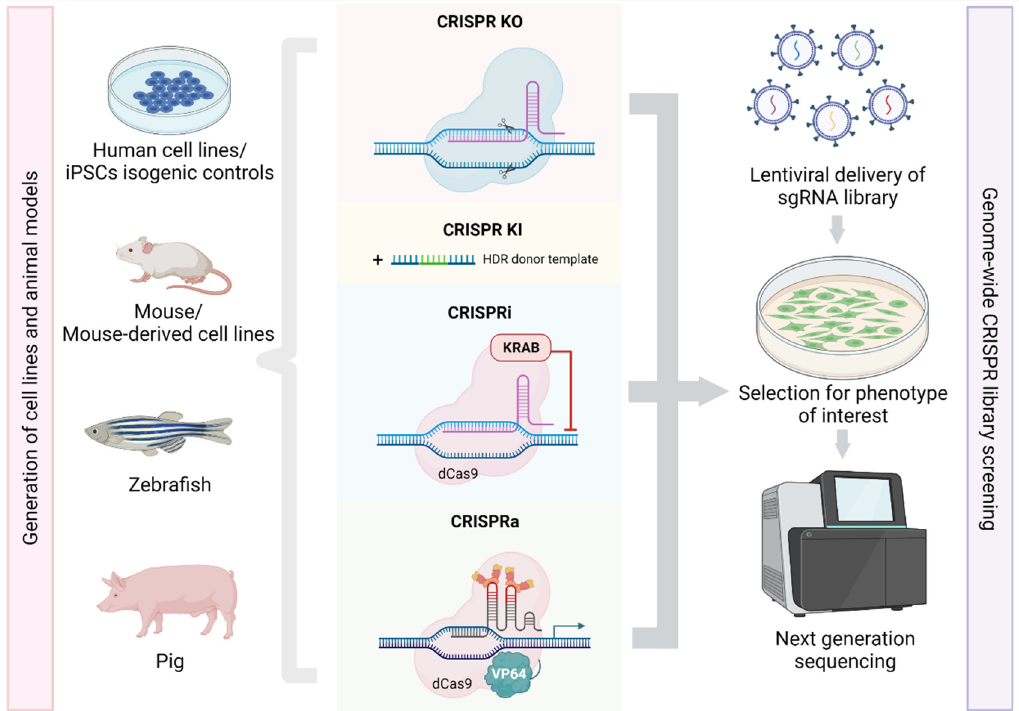
Figure 1. Implementation of CRISPR/Cas9 technologies in biomedical research. The CRISPR/Cas9 system is a highly accurate and efficient genome editing tool that has been exploited for gene knockout (CRISPR-KO), gene knock-in (CRISPR- KI), and transcriptional inhibition (CRISPRi) or activation (CRISPRa) utilising the catalytically inactive dCas9 and the e.g., repressor KRAB or activator VP64 domain, respectively. These methods have been taken advantage of to generate reliable cell and animal models, to dissect basic mitochondrial functions and pathomechanisms. CRISPR/Cas9 gene editing has been also widely used to generate isogenic controls from human-derived iPSCs, thus minimising experimental variability due to different genetic backgrounds. A recent avenue of CRISPR/Cas9 technology is genome-wide CRISPR screening to uncover new genetic factors under specific selection pressure. The sgRNA library is usually delivered into cell lines via lentiviral particles, and following the selection process, the cell population is sequenced using next generation sequencing platforms and the top hits are identified. Created with Biorender.com (accessed on 15 September 2021).